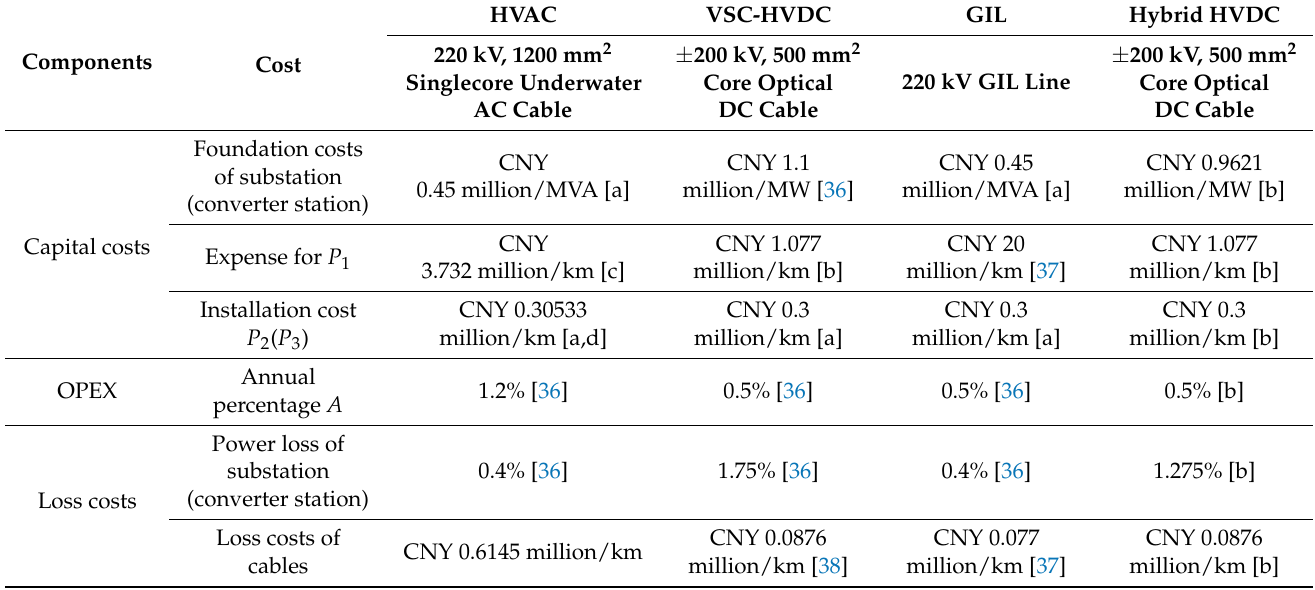
Table 2. Overview of basic data related to the economic evaluation of offshore wind farm